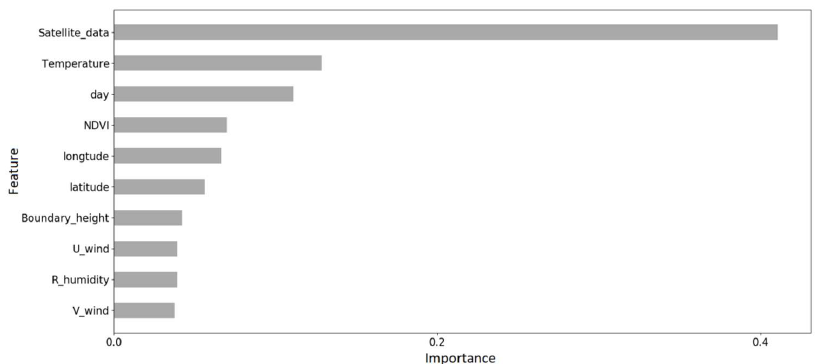
Figure 5. Ranking diagram of the importance of explanatory variables to the model. The correlation between explanatory variables and dependent variable, i.e., the near-surface NO 2 concentration at the ground site, was calculated and the results are shown in Figure 6. It can be seen that the correlation between the ground NO 2 concentra- tion and the satellite inversion product is the best, at 0.42, and the satellite product is al- so of primary importance in the model. The importance of the day factor is good and the correlation with the ground NO 2 concentration is 0.23. The V wind component has a good negative correlation with the ground NO 2 concentration, at −0.39. It can also be seen from Figure 6 that the correlation between explanatory variables is not high, and some variables have almost no relationship with each other. These results suggest that these explanatory variables meet the conditions of mutual independence and can be se- lected for model regression analysis. Figure 6. Distribution of correlation coefficients (CCs) between explanatory variables and depend- ent variables.